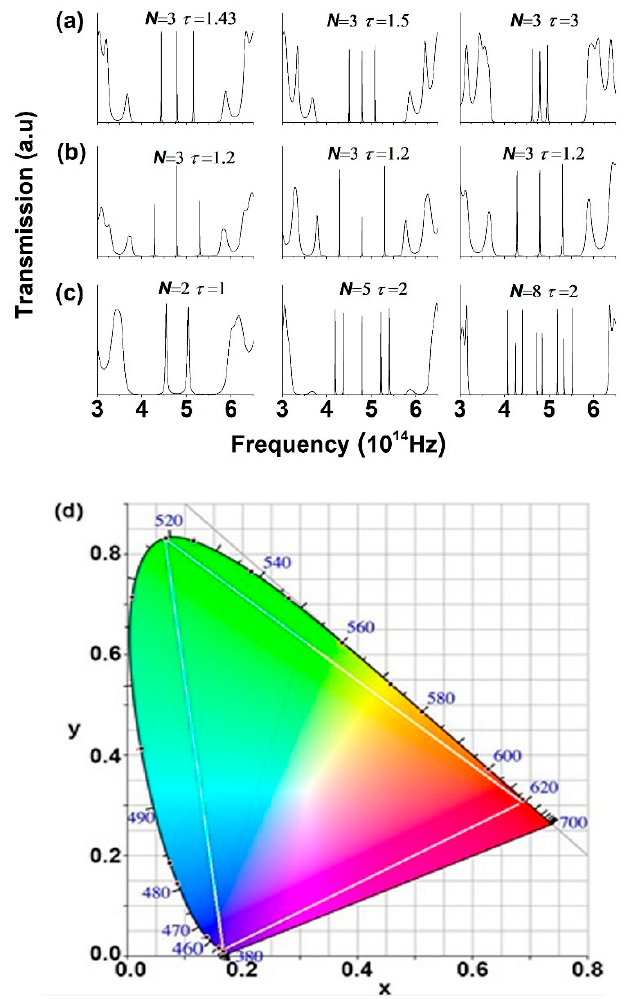
Figure 4. ( a ) Modes splitting for N = 3 with τ = 3, 1.5, 1.43. ( b ) Intensity of optical modes for different boundary layers. ( c ) The number of optical modes for different number of defects. ( d ) Schematic diagram of the emission spectra for the R, G and B